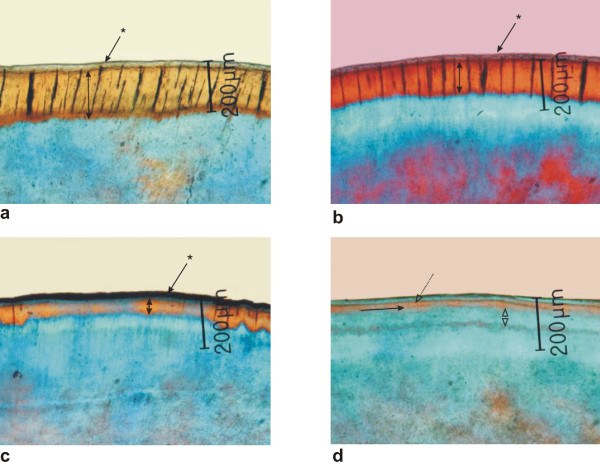
Polarized light micrographs of morphological examples of the 4 groups of control and experimental teeth. a) Negative control N: Homogeneous surface zone, demineralized body of the lesion with no laminations; arrow with asterisk = surface zone, double arrow = body of the lesion. b) Positive control P: Homogeneous surface zone, smaller body of the lesion, detectable translucent zone; arrow with asterisk = surface zone, double arrow = body of the lesion. c) Experimental group D1: homogeneous surface zone, small band of the body of the lesion, detectable translucent zone arrow with asterisk = surface zone, double arrow = body of the lesion. d) Experimental group D2: Homogeneous surface zone, disappearing body of the lesion with laminations, broad translucent zone; dotted line with outlined arrow = laminated body of the lesion, arrow = laminations; double outlines arrow = translucent zone.